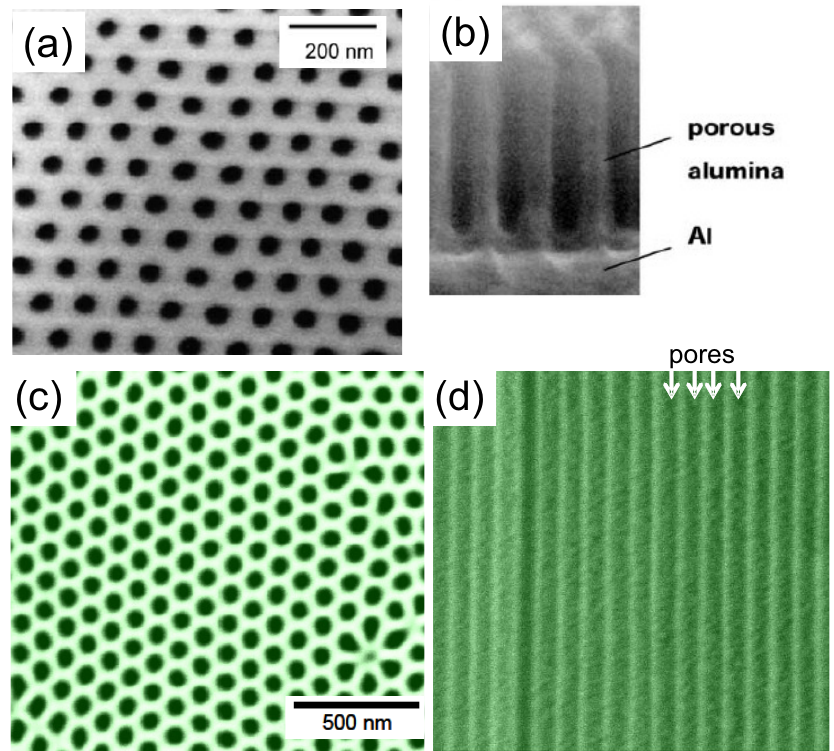
Figure 1. SEM images of anodic alumina oxide (AAO) templates. ( a ) Top-view of a self-fabricated AAO template and view of the cross section ( b ), illustrating the porous alumina layer and the Al 2 O 3 /Al underlayer (Reprinted with permission from Ref. [32]. Copyright 2003 Springer Nature). For comparison, a commercial AAO template (Whatman anodisc™, unframed, nominal pore diameter 100 nm [37]) is presented as top-view ( c ) and cross section ( d